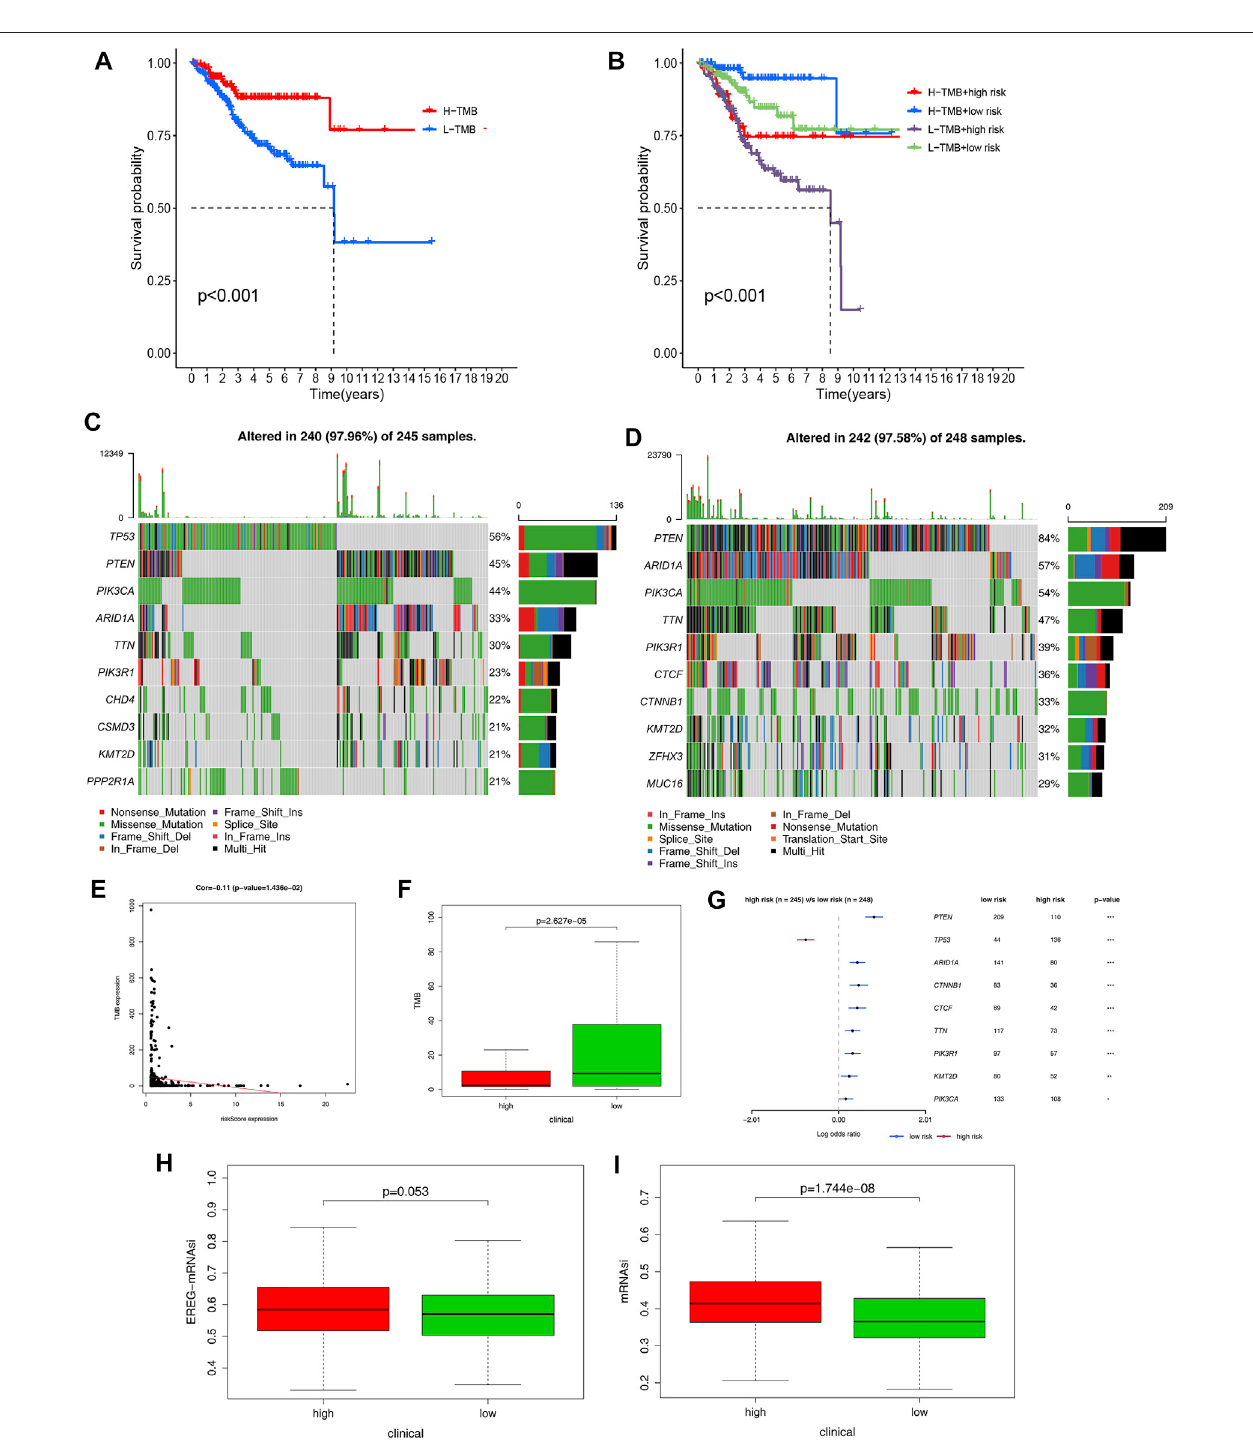
FIGURE 8 | TMB level and Somatic mutation analysis. (A) Survival analysis between patients with high- and low-TMB EC. (B) Two-factor survival analyses of risk score and TMB levels. (C,D) Landscape of mutation pro fi les was shown in the waterfall plot, in which the type of mutation is shown in the comment bar (bottom) and genesareorderedbytheirmutationfrequency. (E) Relationshipbetweentumormutationburden(TMB)andimmune-relatedriskscore. (F) Differencesoftumormutation burden in the high-risk and low-risk groups. (G) Differences of mutated genes between the high- and low-risk groups. (H,I) mRNA stemness indices between the high- and low-risk groups.